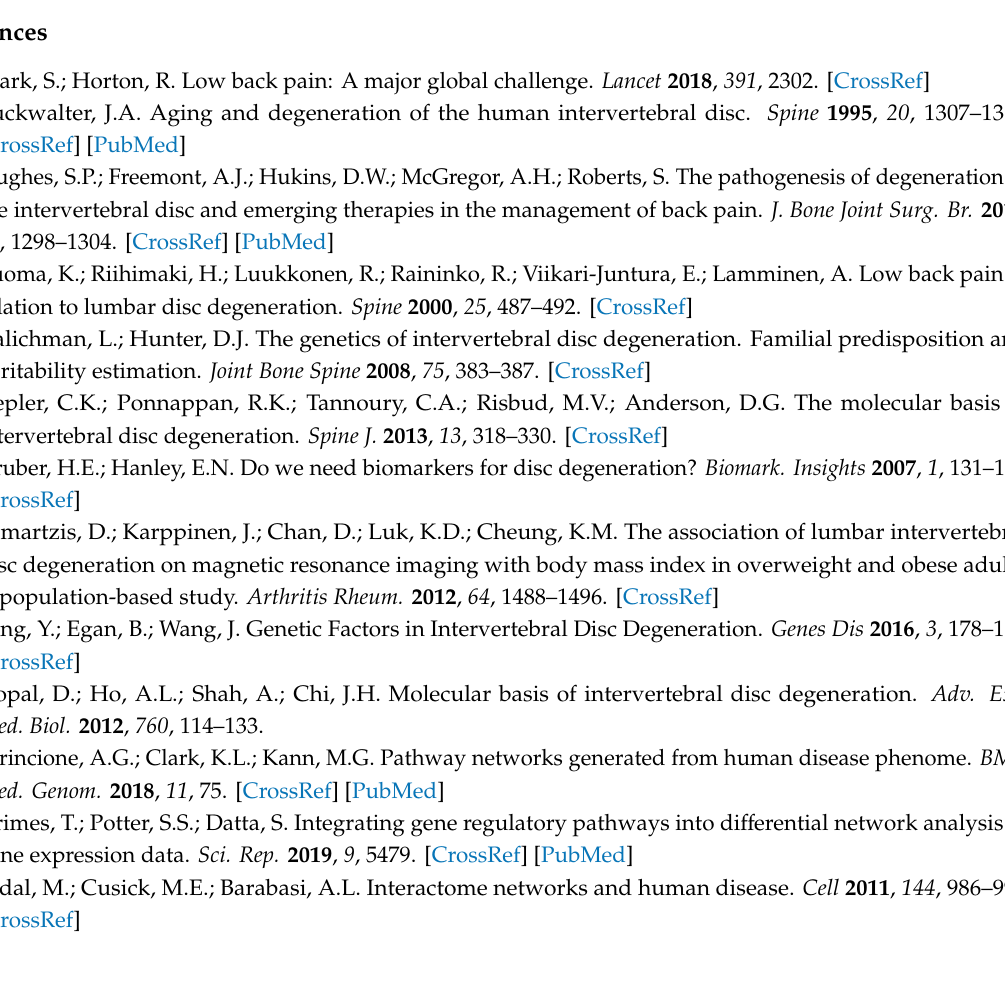
Figure S1: Protein–protein interaction (PPI) network of IDD-related genes formed a significant functional network. PPI network using the STRING database was constructed using experimentally validated interactions with a combined PPI score of > 0.7, which indicates highly significant interactions among hub proteins. Figure S2: Topological properties of PPI network of IDD-related genes. Network analysis of PPI network using several topological features including: (A) Betweenness Centrality, (B) Topological Coe ffi cients, (C) Average Clustering Coe ffi cient and (D) Closeness Centrality. Figure S3: Transcription factor (TF)–gene target regulatory network motif analysis. The iRegulon analysis showed the (A) top transcription factors and (B) enriched track ID in the cis-regulatory regions of the twenty genes of network cluster 1. Table S1: Top 15 biological functions of IDD-related genes. Associated genes or Gene term ratio (%) = number of IDD-related genes / total number in the GO term X 100%; GO: Gene